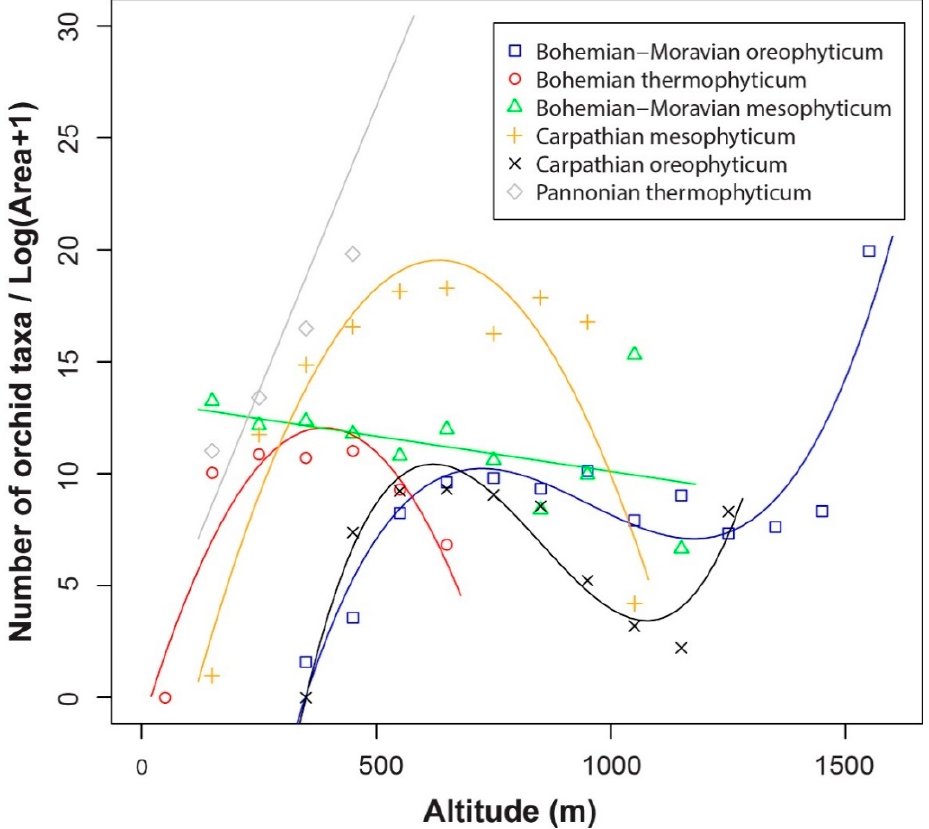
Figure 3. Orchid species density recorded along altitudinal gradients in each of the phytogeographical regions in the Czech Republic.